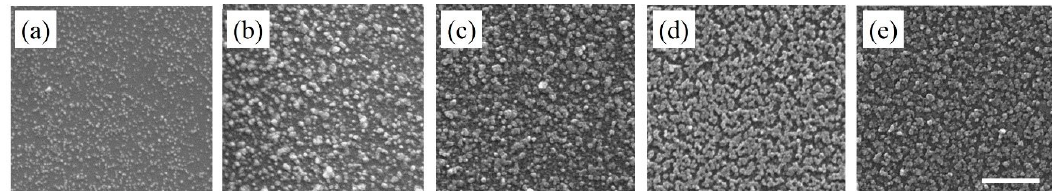
Figure 5. SEM images of Au nanostructures deposited on Si substrate after ( a ) first, ( b ) second, ( c ) third, ( d ) fourth, ( e ) fifth, ( f ) sixth, ( g ) eighth, and ( h ) tenth deposition cycle with CTAB added as surfactant. The scale bar is 500 nm.